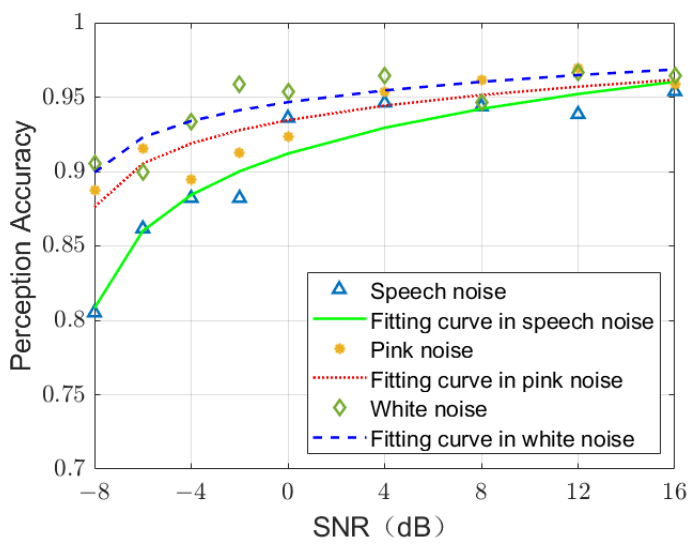
Figure 3. Voice identity perception in different noise environments.